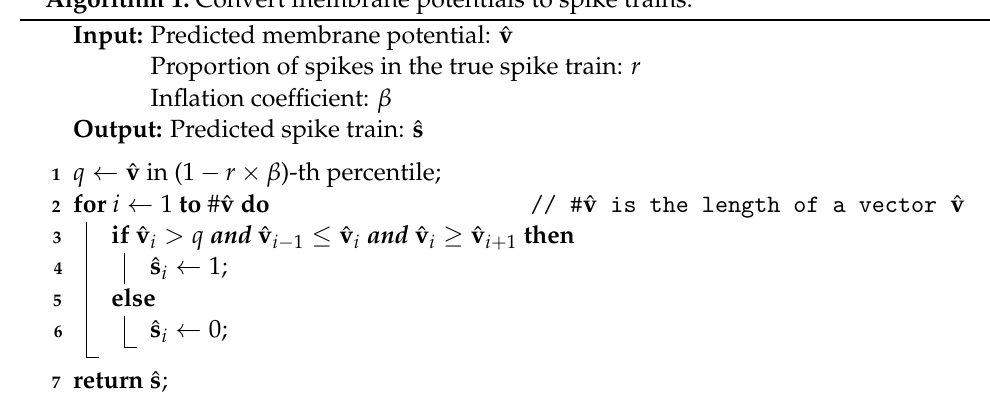
Algorithm 1: Convert membrane potentials to spike